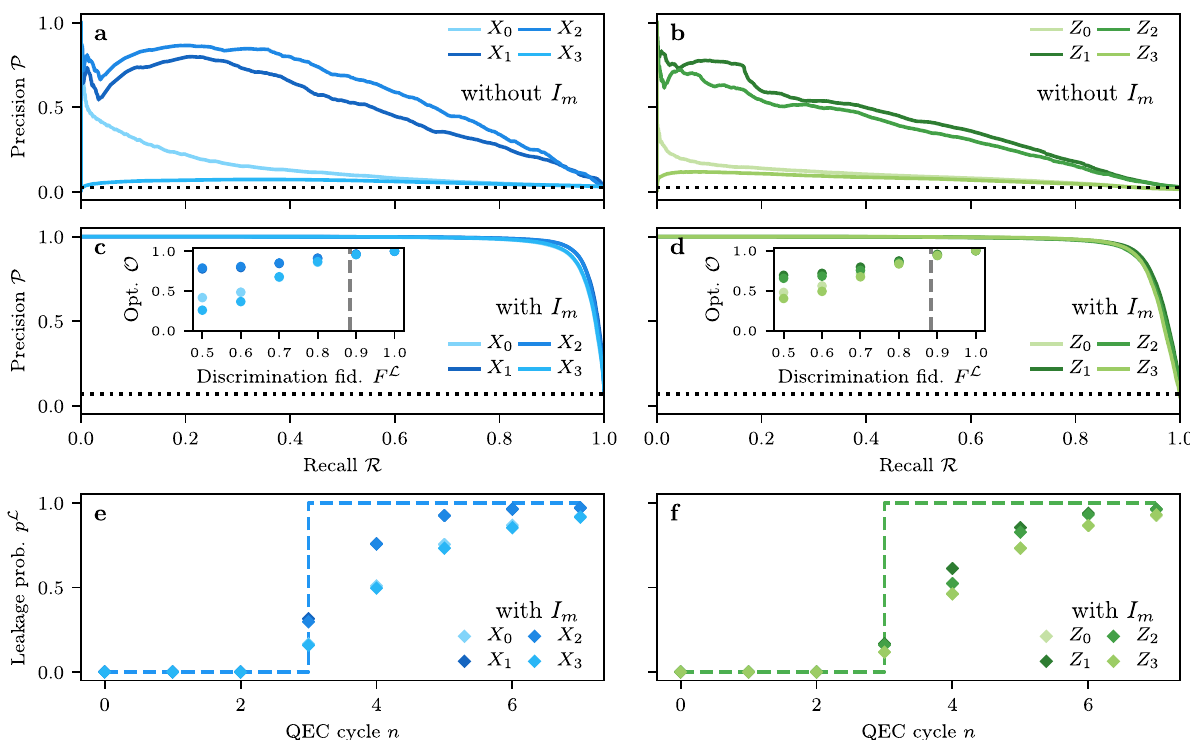
Fig. 6 Ancilla-qubit leakage detection. a – d Precision-recall curves for the ancilla-qubit HMMs over 4 × 10 4 runs of 50 QEC cycles each. In a , b the HMMs rely only on the observed defects on the neighboring stabilizers. In c – f the HMMs further get the in-phase component I m of the analog readout as input, from which p L m is extracted. The dotted line corresponds to a random guess classi fi er for which P is equal to the fraction of leakage events over all QEC cycles and runs. As ancilla-qubit leakage is directly measured, P DM ¼ 1 for all values of R (not shown). Insets in c , d : the HMM optimality O as a function of the discrimination fi delity F L between 1 j i and 2 j i . The corresponding error bars (extracted over 2 × 10 4 runs of 20 QEC cycles each) are smaller than the symbol size. The vertical dashed line corresponds to the experimentally measured F L ¼ 88 : 4 % . e , f Average response in time of the ancilla-qubit HMMs (diamonds) to leakage, in comparison to the actual leakage probability extracted directly from the readout (dashed), extracted over 4 × 10 4 runs of 50 QEC cycles each. The average is computed by selecting single realizations where the qubit was in the computational subspace for at least 3 QEC cycles and then in the leakage subspace for 5 or more.